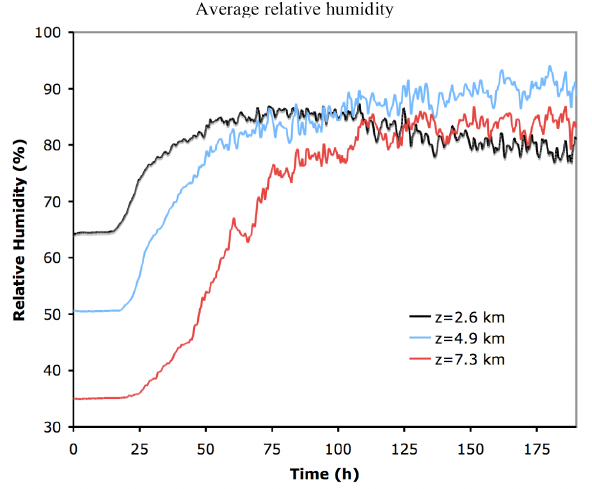
Fig. 7. The average relative humidity for a circular area with radius of 100 km from the vortex center, at levels z = 2 . 6, 4.9 and 7.3 km, for Experiment 3.